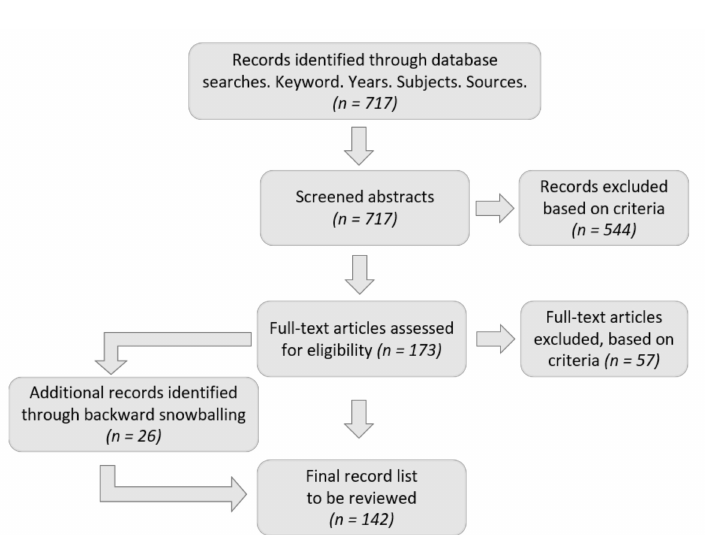
Figure 2. Systematic literature review steps in this